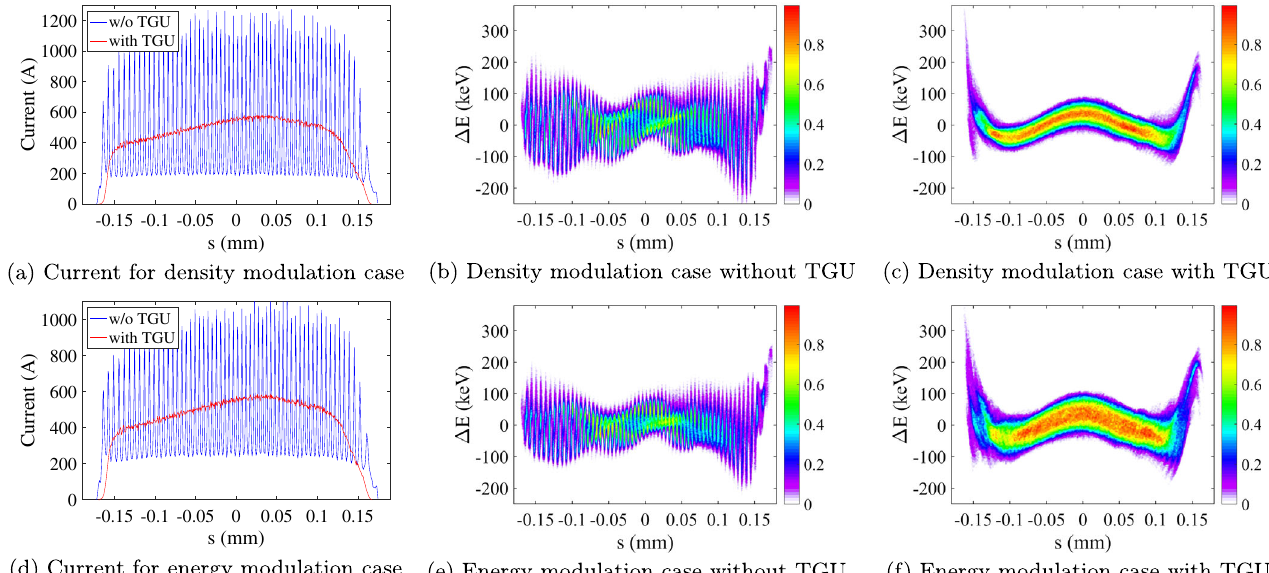
FIG. 6. Suppression of the microbunching instabilities due to the initial density modulation and the initial energy modulation, i.e., simulating the initial collective effects driven modulation and the internal collective effects driven modulation. Current profiles (a, d) and longitudinal phase space (b, c, e, f) are presented. Energy chirps up to the 2nd order are removed. compression factor and the reversed slice energy spread to a tolerable level, and the core horizontal emittance is also increased by less than 10 percent. Besides, the energy jitter